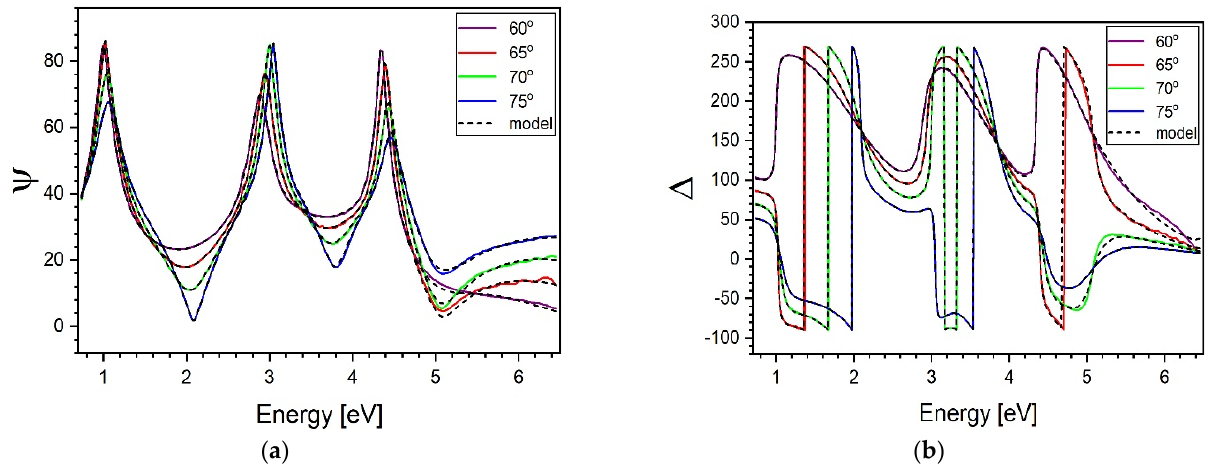
Figure 2. The 20% sample. Ellipsometry angles ψ and Δ (full lines, plots ( a ) and ( b ), respectively) measured at different incidence angles as a function of photon energy. Dashed lines represent curves modelled using Tauc-Lorentz approximation (discussed in the further text).